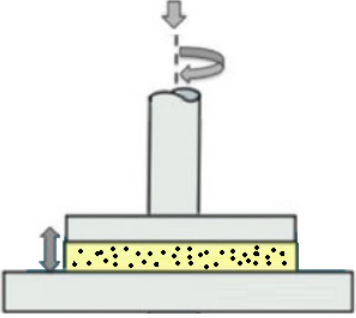
Figure 2. Rotational parallel-plate configuration scheme.